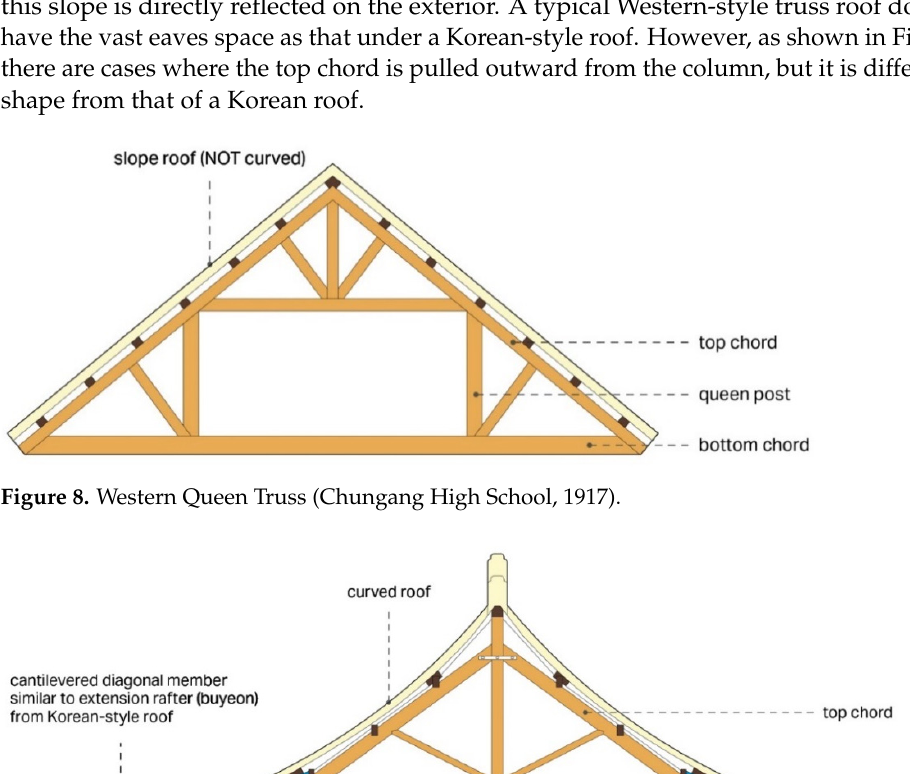
Figure 9. Hybrid Roof Structure—Triangular Arrangement of Structural Members and Additional Members Added to the Truss Structure to Articulate Roof Curve and Eaves Space (Korea Pavilion, Tokyo Taisho Exhibition, 1917).